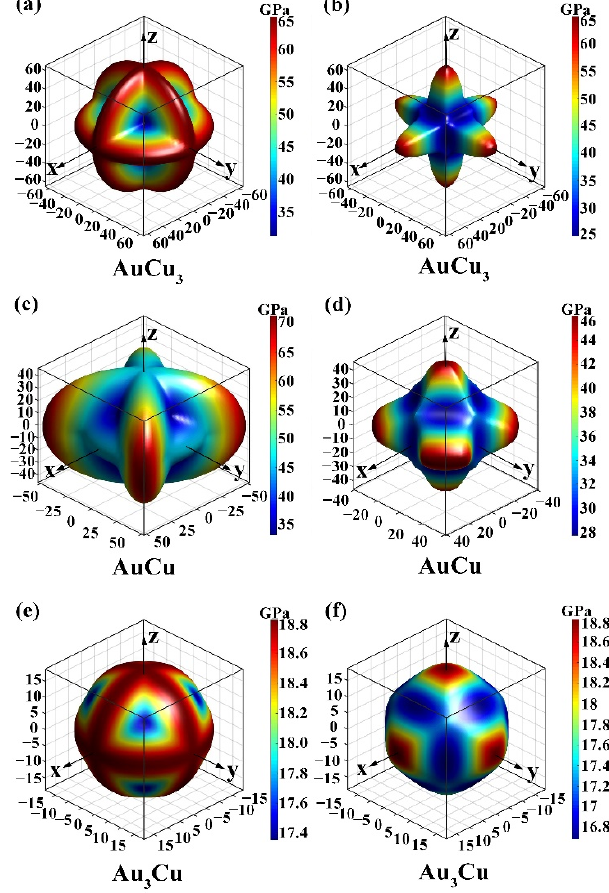
Figure 5. Direction dependence of shear modulus: ( a ) maximum shear modulus of AuCu 3 ; ( b ) min- imum shear modulus of AuCu 3 ; ( c ) maximum shear modulus of AuCu; ( d ) minimum shear modulus of AuCu; ( e ) maximum shear modulus of Au 3 Cu; and ( f ) minimum shear modulus of Au 3 Cu.